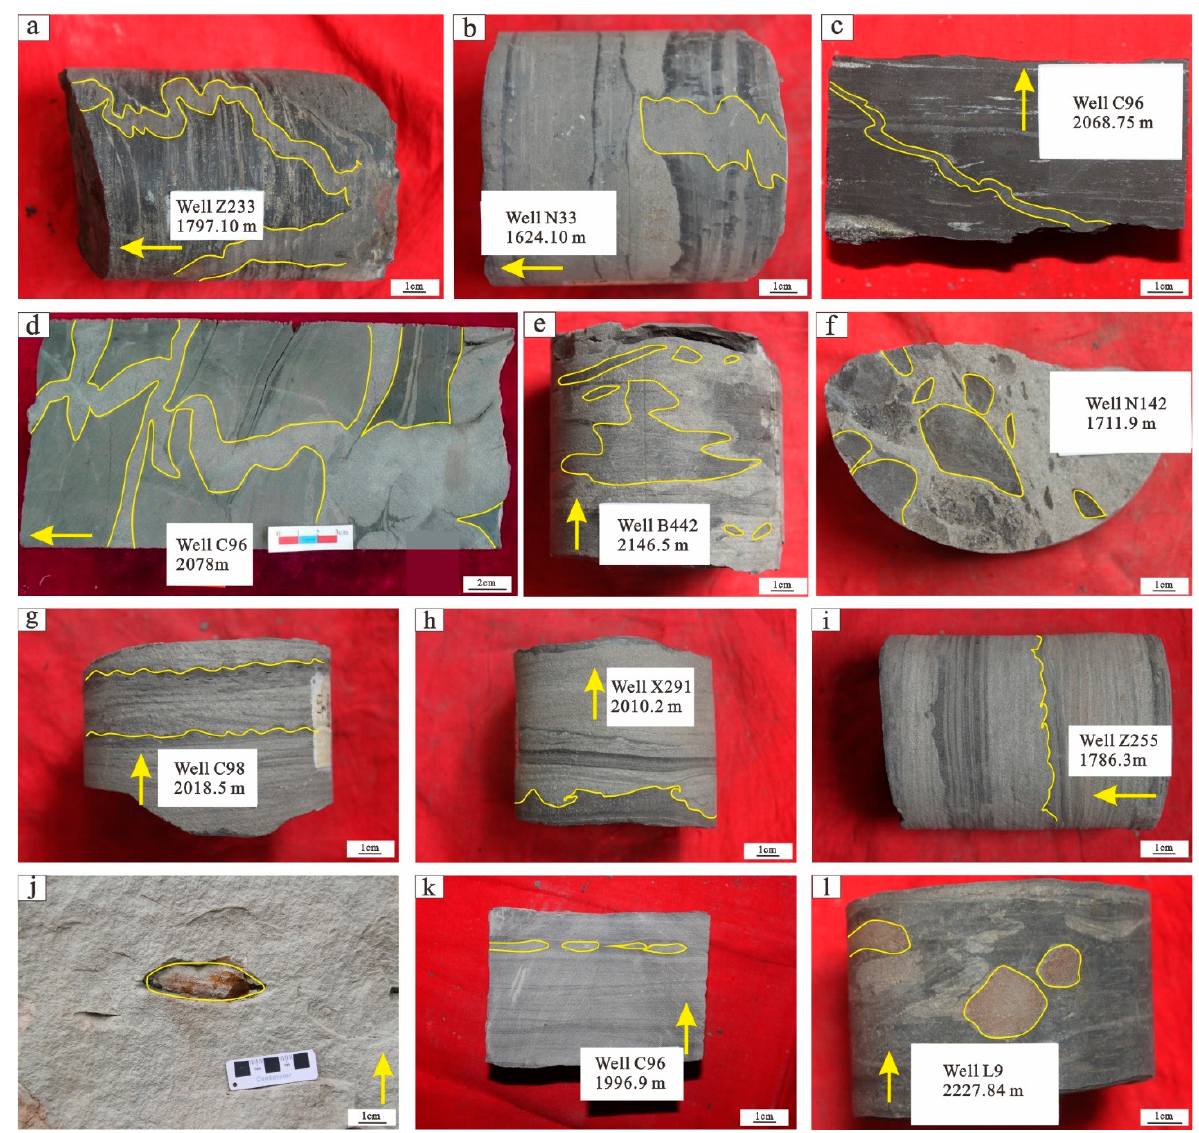
Figure 2. Soft-sedimentary deformation structures ( a ): Well Z233, Chang-7 Member, 1797.10 m, liquefied sand dyke; ( b ): Well N33, Chang-7 Member, 1624.10 m, liquefied sand dyke; ( c ): Well C96, Chang-7 Member, 2068.75m, liquefied sand dyke; ( d ): Well C96, Chang-7 Member, 2078.00 m, liquefied sand dyke; ( e ): Well B442, Chang-7 Member, 2146.50 m, liquefied sand dyke; ( f ): N142, Chang-7 Member, 1711.90 m, liquefied breccia; ( g ): Well C98, Chang-7 Member, 2018.50 m, load structure; ( h ): Well X291, Chang-7 Member, 2010.20 m, injection structure; ( i ): Well Z255, Chang-7 Member, 1786.30 m, flame structure; ( j ): Yaoqu-1, Chang-7 Member, ball structure; ( k ): Well C96, Chang-7 Member, 1996.90 m, pillow layer; ( l ): Well L9, Chang-7 Member, 2227.84 m, ball structure.